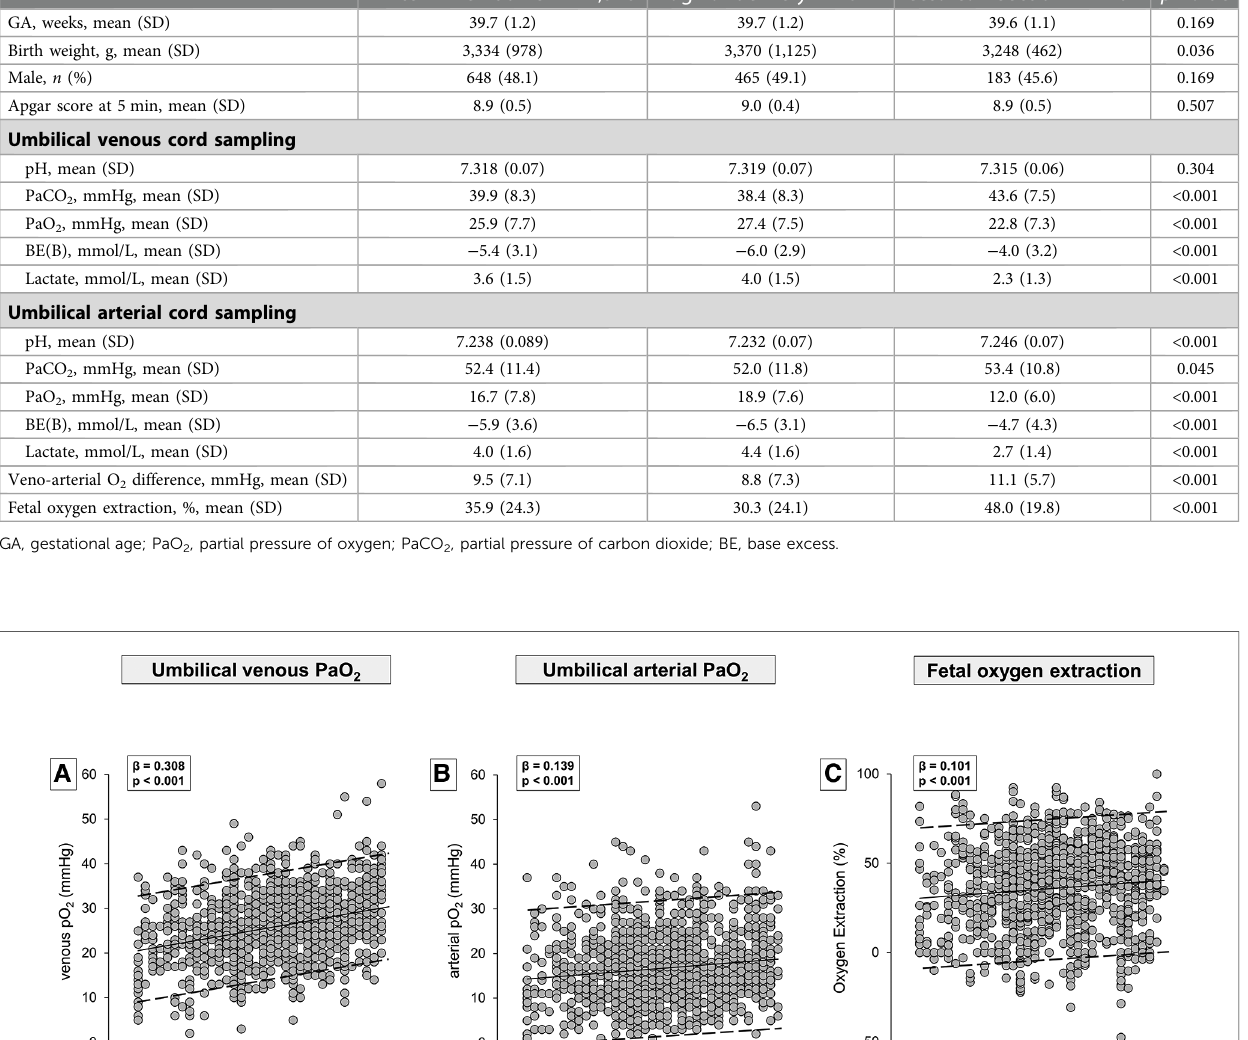
( p = 0.065), and oxygen extraction was 48.2 ± 24.6% vs. 47.5 ± 22.8% ( p = 0.553). There was no statistical difference between the newborns